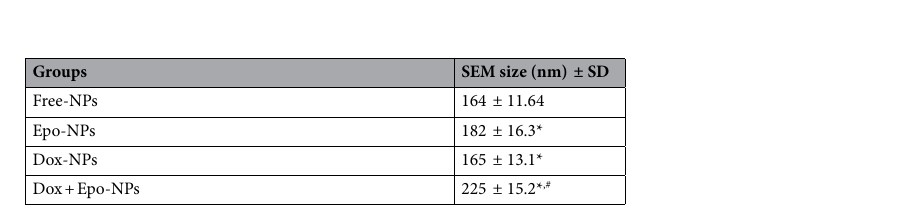
Table 2. Mean size values of NPs as determined by SEM image analysis. *Values of treatment groups are significantly different from those of free-NPs (p < 0.01). # Value of Dox + Epo-NPs is significantly different from those of the Dox-NPs and Epo-NPs (p <